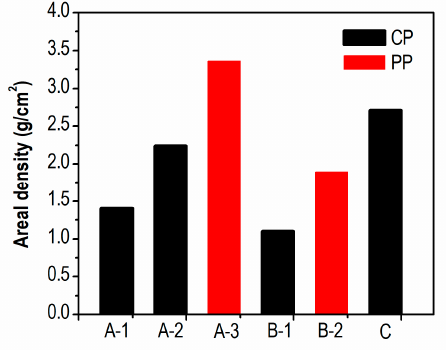
Figure 8. The areal density of the rear walls and the experimental results.